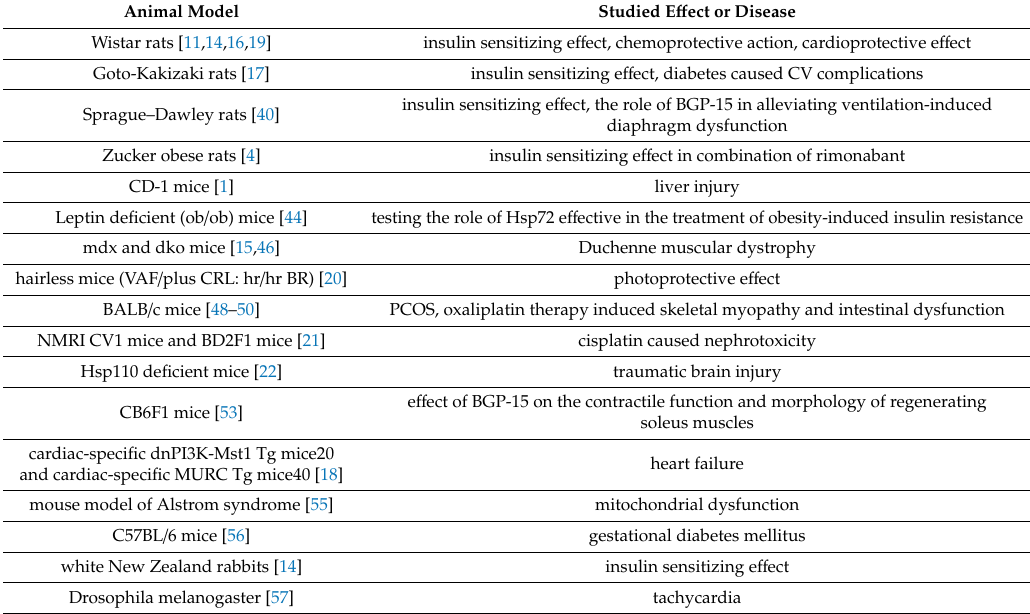
Table 1. Summary of the studied e ff ects and diseases, with the help of animal models. Animal